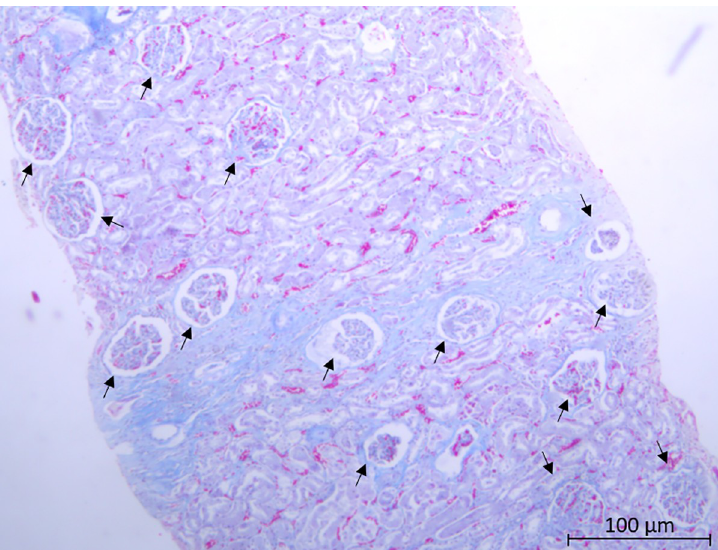
Fig 3. Pig kidney section stained in Hematoxylin and Eosin (HE). Glomerular amount higher than 10 (arrow) in a microscopic field of a cortical region of the kidney (10X